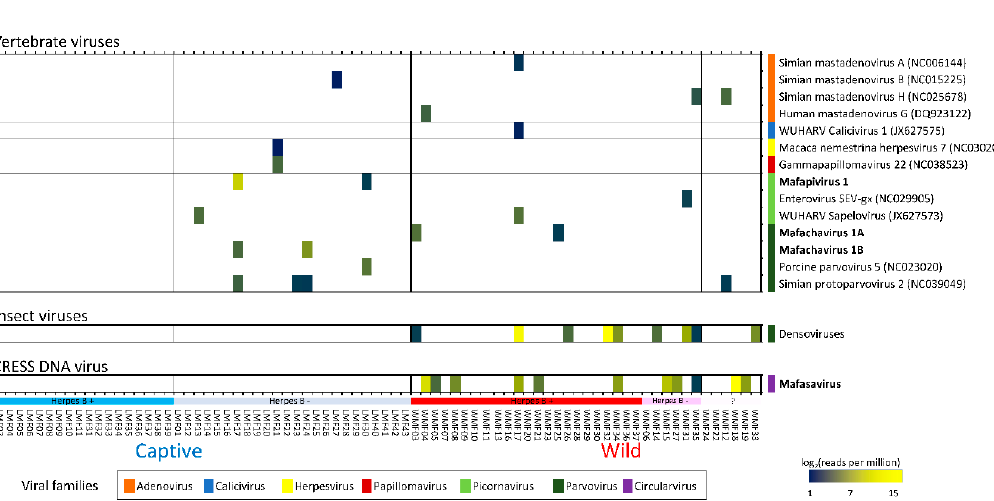
Figure 2. ( A ) Heatmap showing the relative abundance of viral reads identified by BLASTx into families. The families of viruses are grouped by host types; phage, eukaryotic viruses and circular Rep-encoding single-strand (CRESS) DNA virus. ( B ) Heatmap showing quantification of reads matching viral genomes from GenBank or contigs generated here (in bold). Mafapivirus: Macaca fascicularis